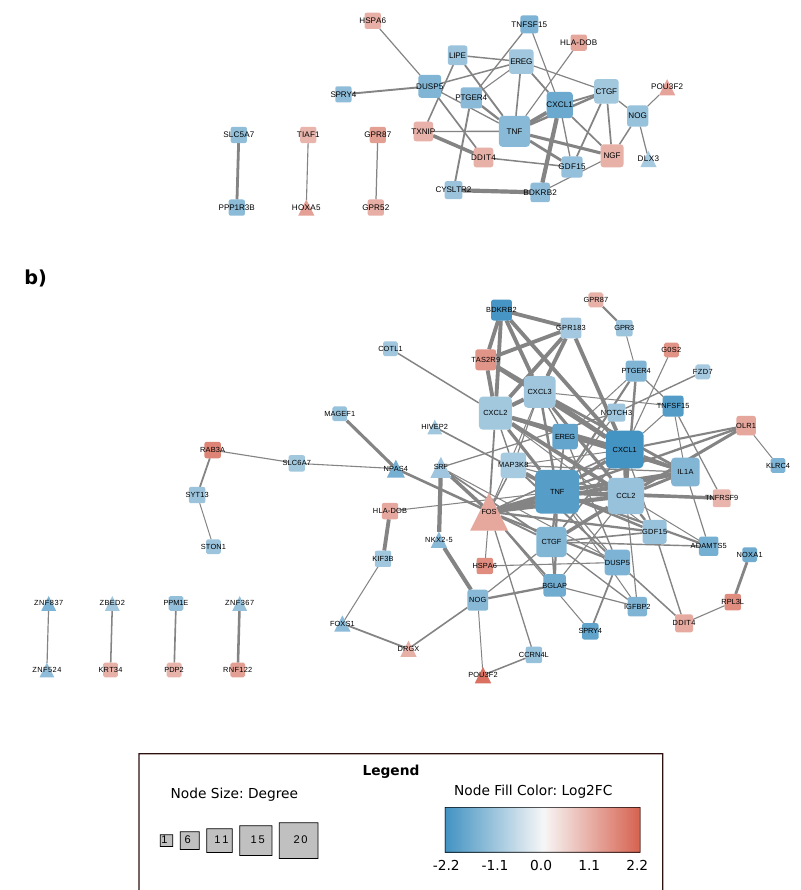
Figure 5. Cytoscape representation of the protein–protein interaction (PPI) network of our sorted DEGs. Representation of the PPI network at ( a ) 4 h and ( b ) 6 h. Network diagrams are useful for visualizing hub proteins and their immediate connections. The red nodes are proteins codified by upregulated genes and the blue nodes proteins codified by downregulated genes. The square nodes are generic proteins and the triangle nodes transcription factors. The connecting lines represent direc- tional co-dependency in expression; the light to dark arrows show moderately-to-highly-interacted scores between the proteins ( p -value < 0.05 and log 2 FC < − 1/+1). The size of a node is proportional to the number of connecting lines